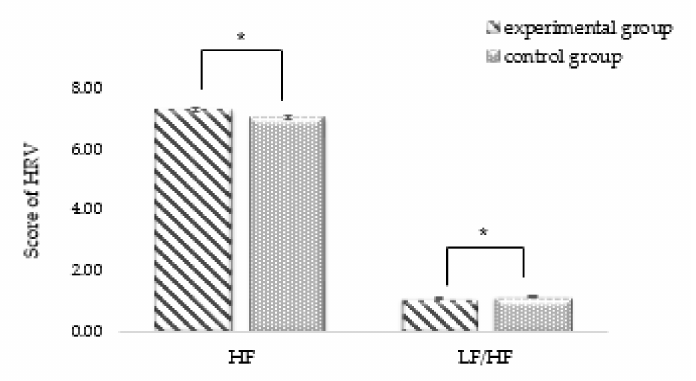
Figure 4. The effect of forest therapy on HRV by comparing experimental and control groups, * p <